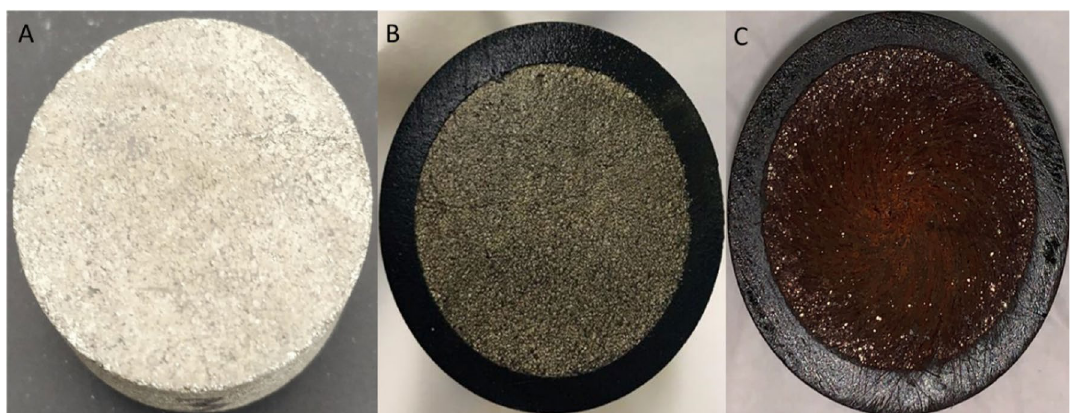
Figure 5. Pyrite samples: (A) before reaction (B) after chemical reaction with DTPA/K 2 CO 3 solution (C) after electrochemical reaction in DTPA/K 2 CO 3